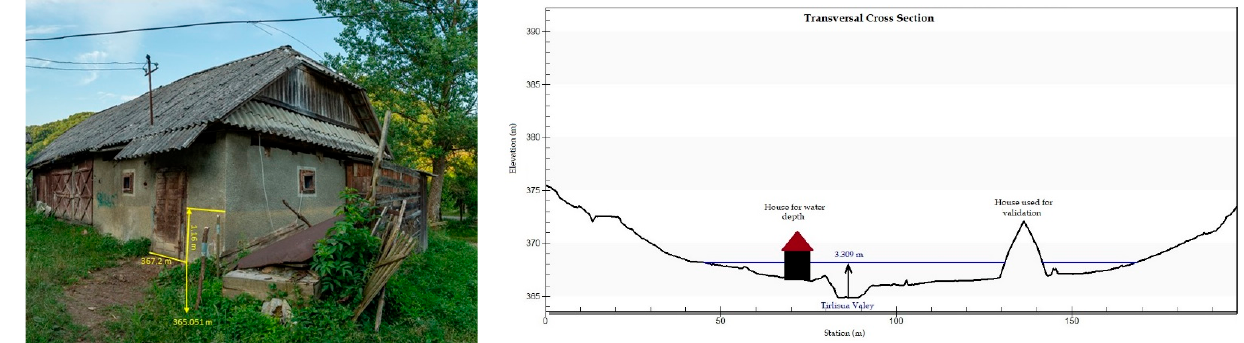
Figure 4. Cross-sectional profile used for the calculation of the maximum flow in the section. For the calculation of the maximum flow of the flash flood and its insertion as an alphanumerical database in the hydraulic simulation model, the water level related to the altitude of the drainage channel thalweg was used. To achieve the water depth and level, GNSS RTK measurements were conducted for the identification of the reference building’s footprint (367.2 m) and the water height on the respective building (1.16 m). The drainage